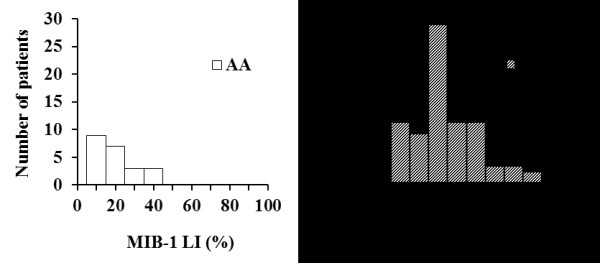
Distributions of MIB-1 LI. Distributions of MIB-1 LI in patients with AA
(n = 22) and in patients with GB (n = 79).